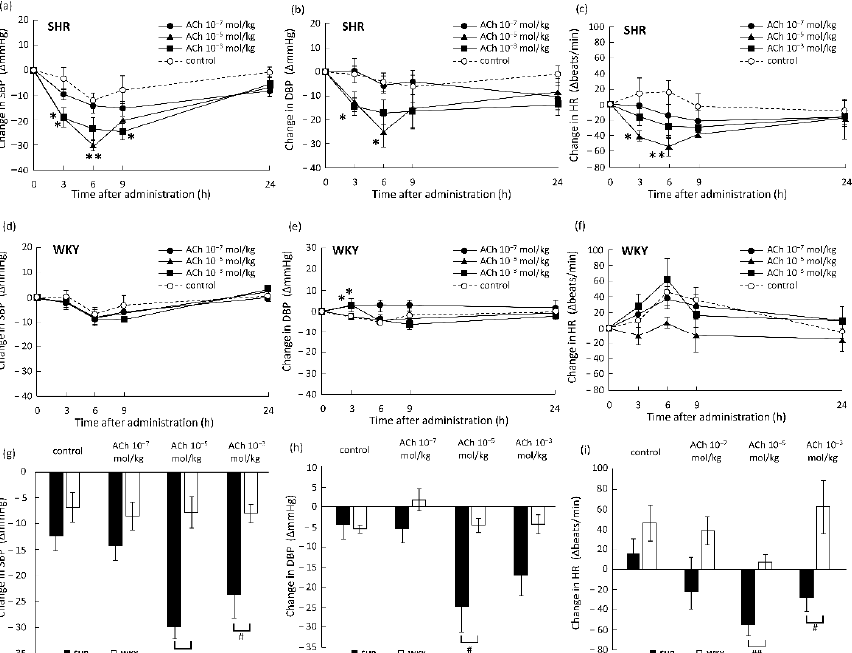
Figure 2. Changes in SBP ( a , d ), DBP ( b , e ), and HR ( c , f ) in SHRs ( a – c ) and WKY rats ( d – f ) after oral